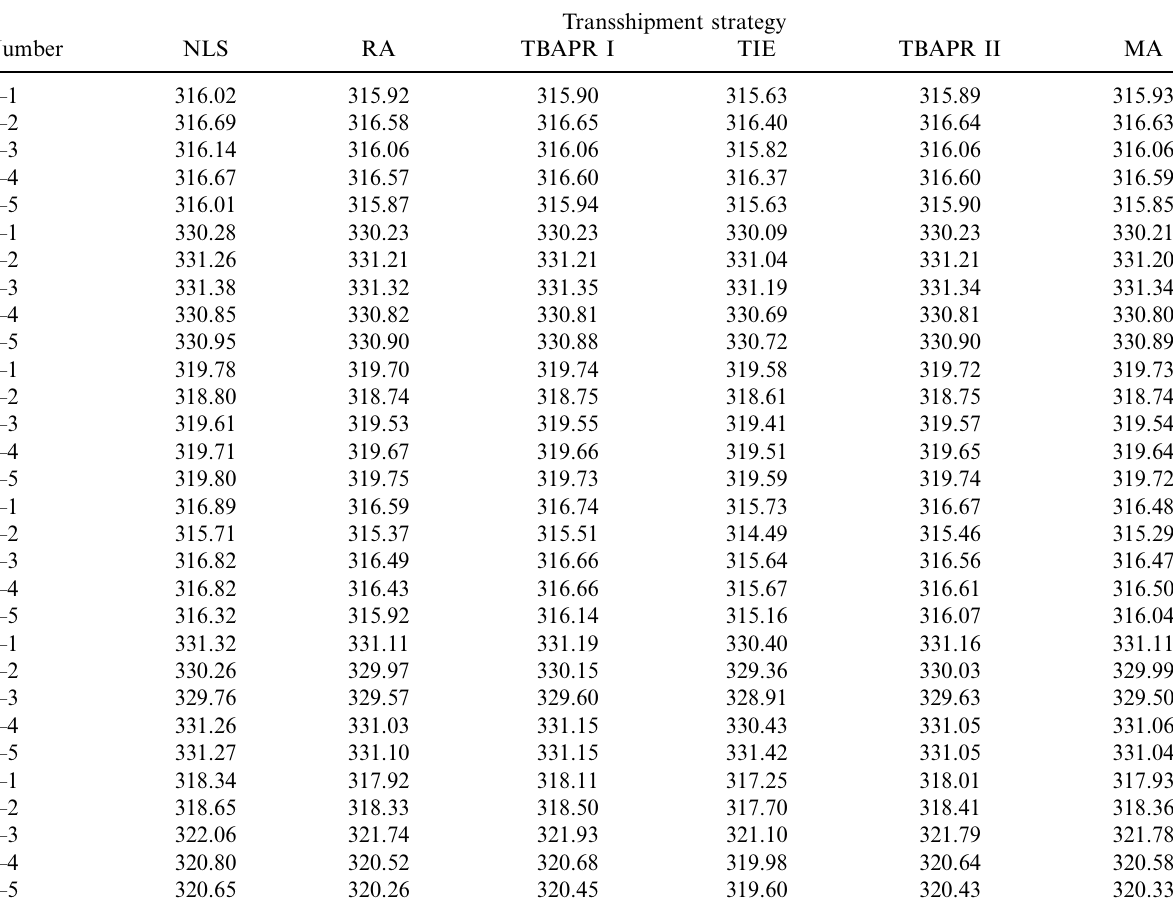
Table 5. Inventory level for the three retailers system